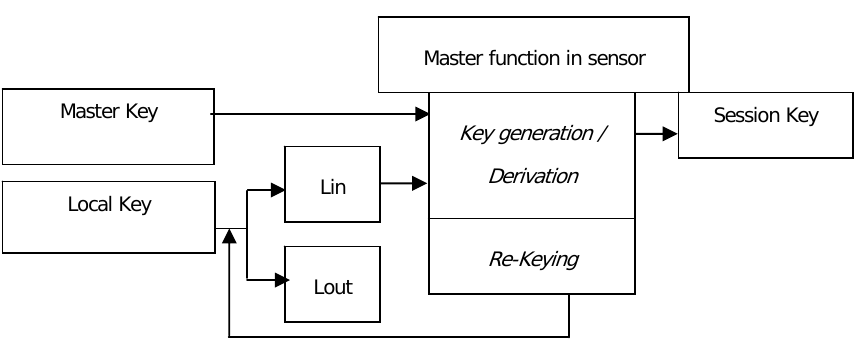
Figure 1. Novel Re-keying Function Protocol